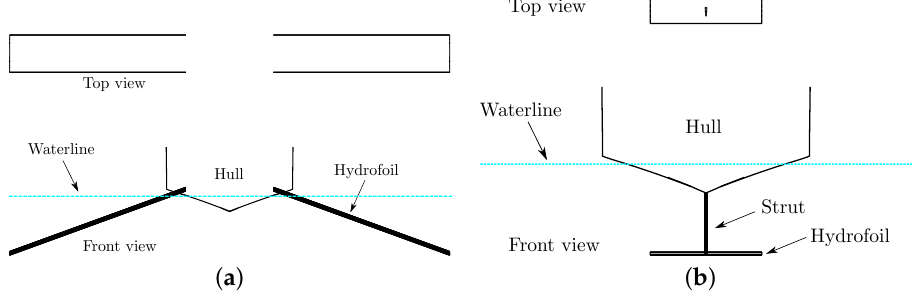
Figure 1. Hydrofoil configurations. ( a ) Surface-piercing Hydrofoil; ( b ) Strut-based